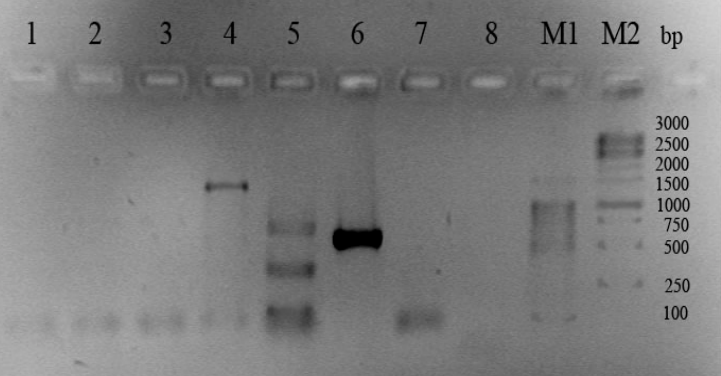
Figure 2. Gel electrophoresis of PCR products of the new molecular markers in the strains C. crus- tatorum JCM 15644 T and C. crustatorum KMM 6817. Lane numbers: 1 —DNA/RNA non-specific